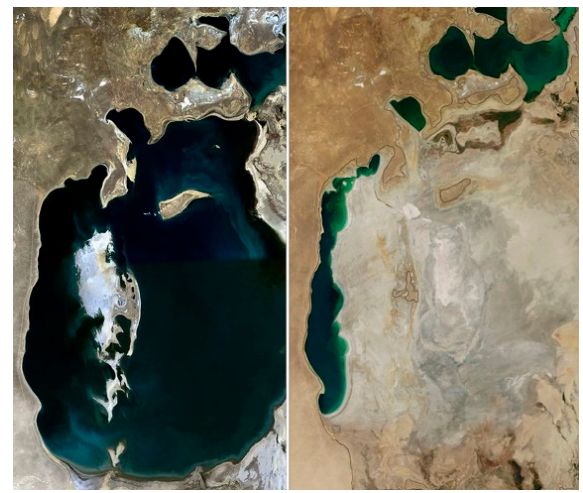
Figure 8. Aral Sea before and after diversions.